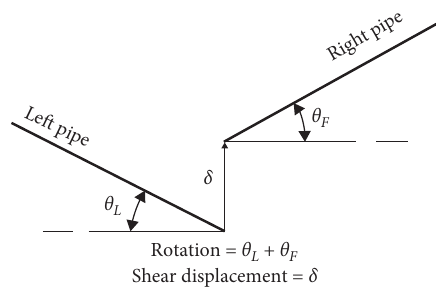
Figure 10: Definition of joint rotation and shear